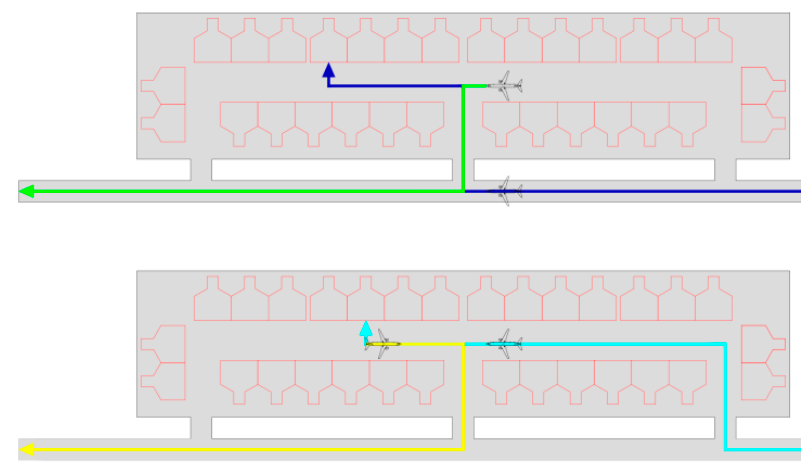
Figure A2. Taxiway conflicts.